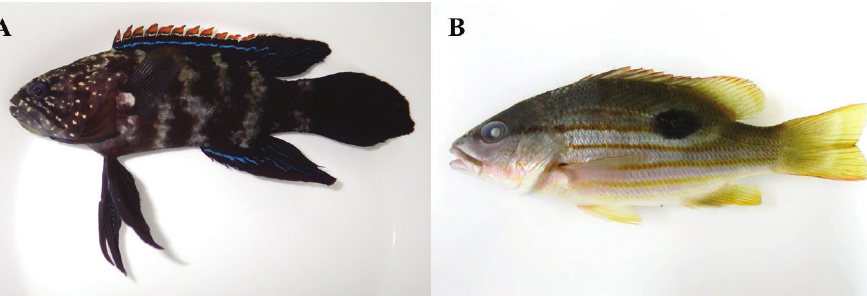
Figure 6. A Plesiops coeruleolineatus , MFD-860, 82.8 mm SL B Lutjanus fulviflamma , MFD-866, 101.1 mm SL.